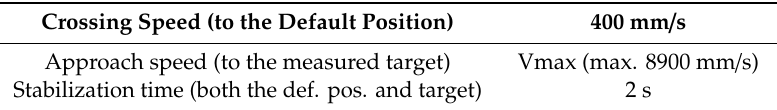
Table 3. Robot measurement movement parameters.